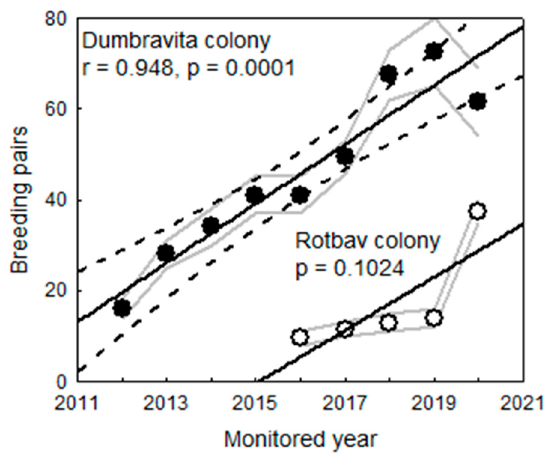
Figure 12. Population trends over the last 10 years.